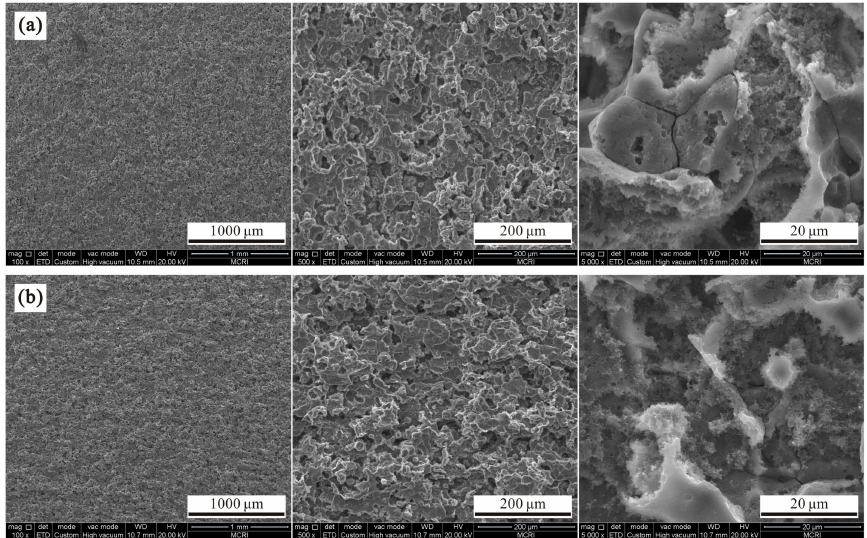
Figure 2. Scanning electron microscopes images at various magnifications of 7075 aluminum alloys after etching for ( a ) 7 min and ( b ) 9